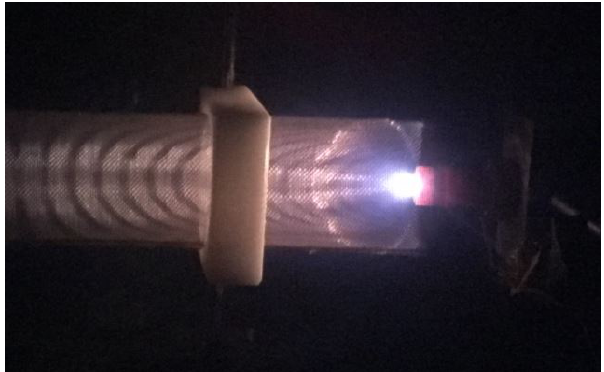
Figure 12. Picture of the steady operation of the coaxial hollow cathode after the heater is turned off during its characterization